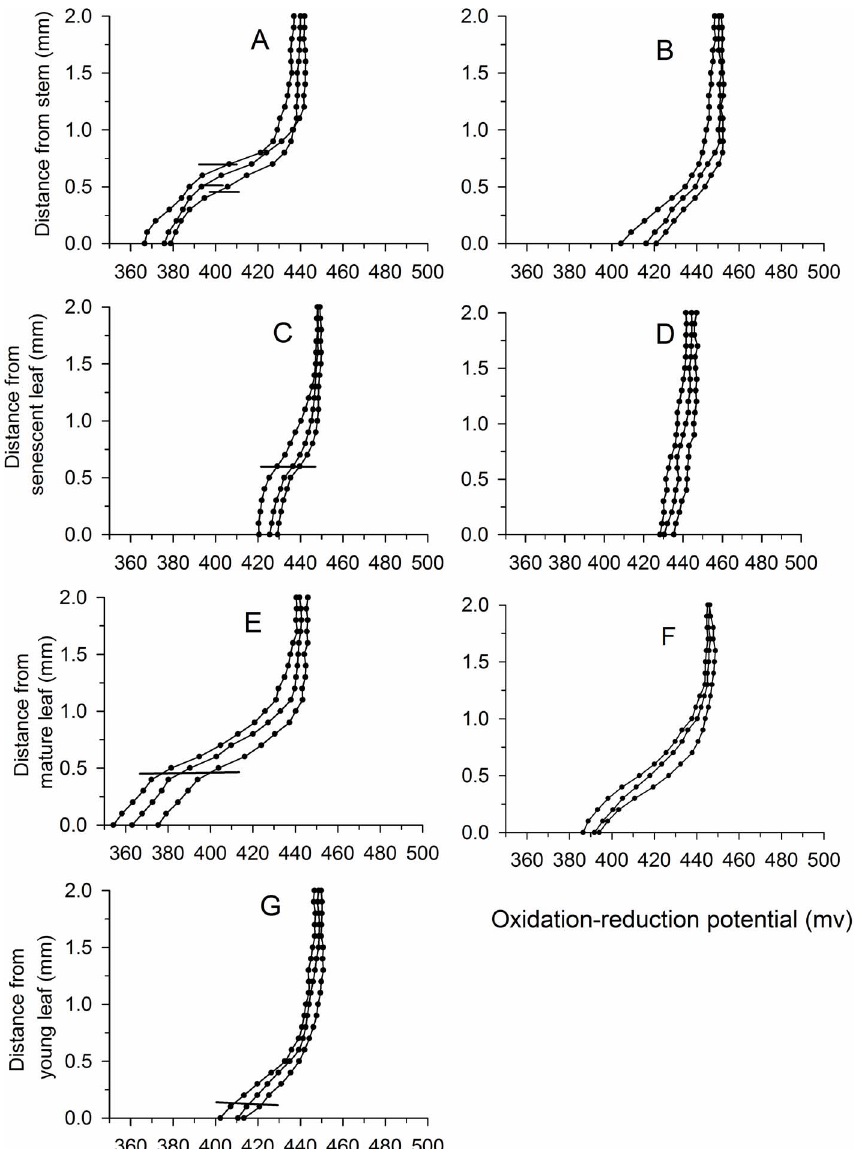
Figure 4. Microprofiles of oxidation-reduction potential around Potamogeton malaianus stems and leaves with and without periphyton. A, C, and E, indicate thick periphyton; B, D, and F indicate periphyton removed; G indicates young leaves with little periphyton. Microprofiles were measured at three different points under quantum flux density of 300 m mol photons ? m –2 ? s –1 on P. malaianus stems and leaves. The outer surfaces of the periphyton layer are indicated by horizontal bars. The leaf surfaces are indicated by 0. Microprofiles of oxidation-reduction potential around young leaves were not markedly different between the presence of little periphyton and periphyton removed.